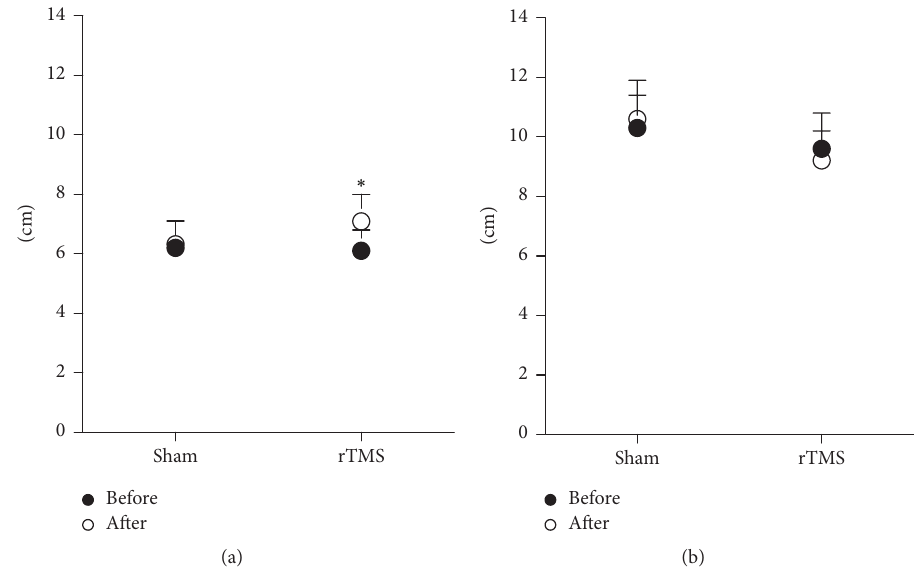
Figure 5: Grasp aperture for the small object (a) and the large object (b) pre ( e ) and post ( I ) each TMS condition. ∗ indicates a significant interaction between the TMS condition and time. Error bar =